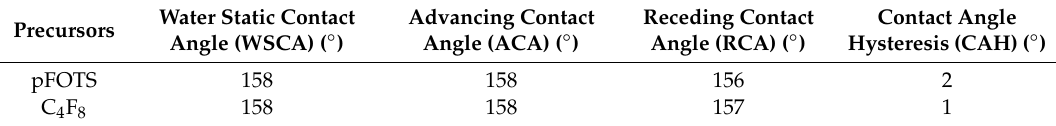
Figure 2. Photographs of a 5 μL water droplet on an oxygen plasma micro-nanotextured (10 min) superhydrophobic PMMA surface coated with ( a ) a fluorocarbon layer from C 4 F 8 plasma deposition (10 s) and ( b ) a fluorinated chlorosilane layer from pFOTS solution. Table 1. Water static contact angle measurements of oxygen plasma micro-nanotextured superhydrophobic PMMA surfaces after the deposition of either a fluorinated chlorosilane layer from perfluorinated octyltrichlorosilane (pFOTS) solution or a fluorocarbon layer from C 4 F 8 gas discharge, alongside with the respective advancing, receding contact angles and contact angle hysteresis.